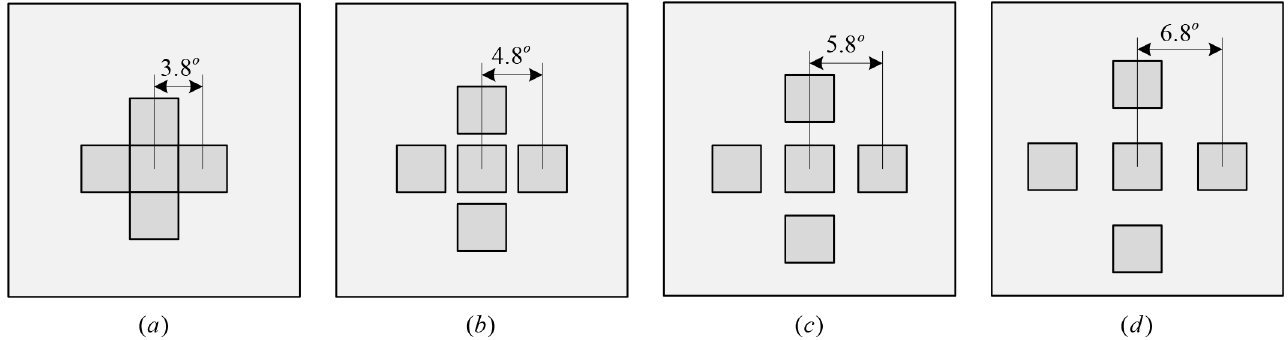
Fig 1. Five square stimuli with different proximities. The four competing stimuli have the same separation with the central stimulus in both horizontal and vertical directions. Stimuli in (a) are closely placed with visual angle 3.8°; Stimuli in (b), (c) and (d) are separately placed with visual angle 4.8°, 5.8° and 6.8°,